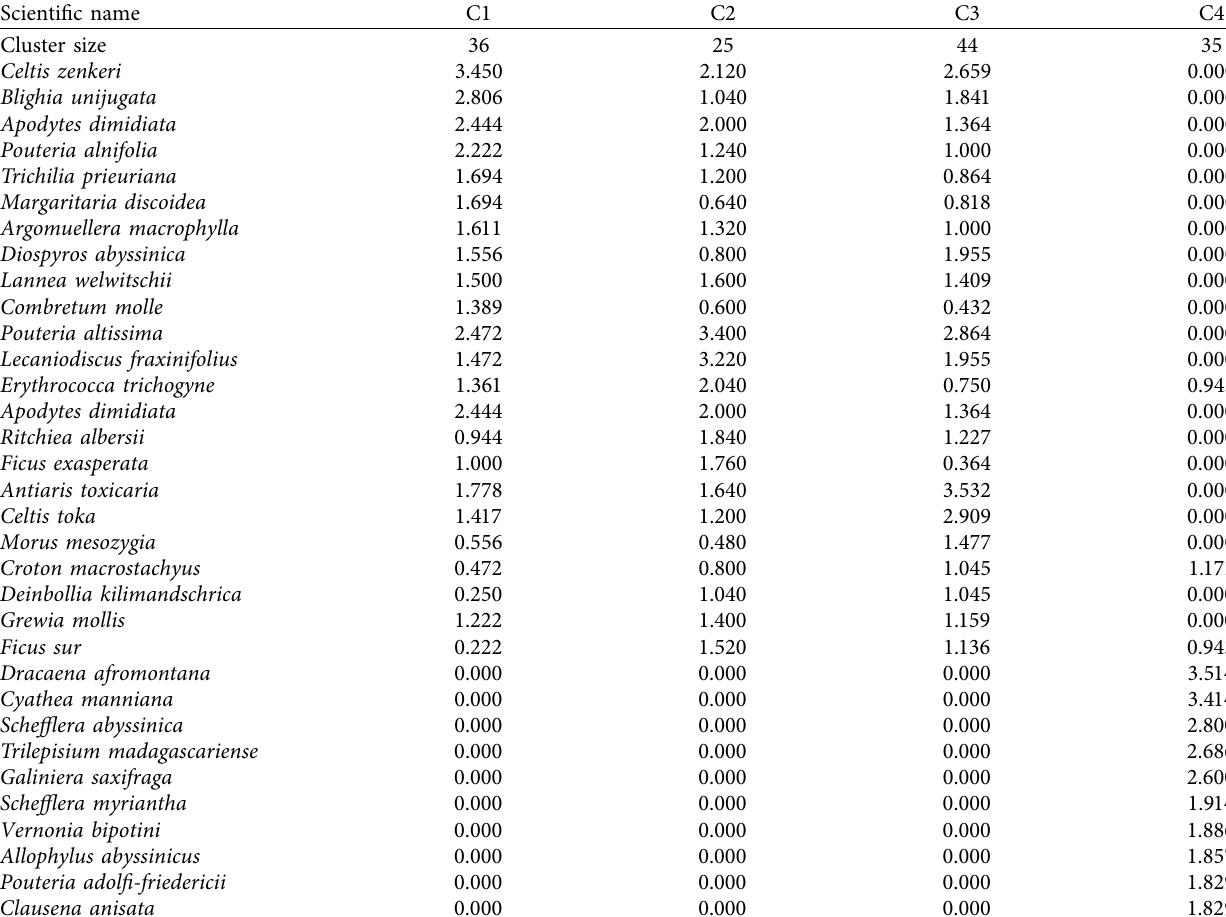
Table 5: Synoptic cover value of plants in MFBR for species ≥ 1% in at least one community.